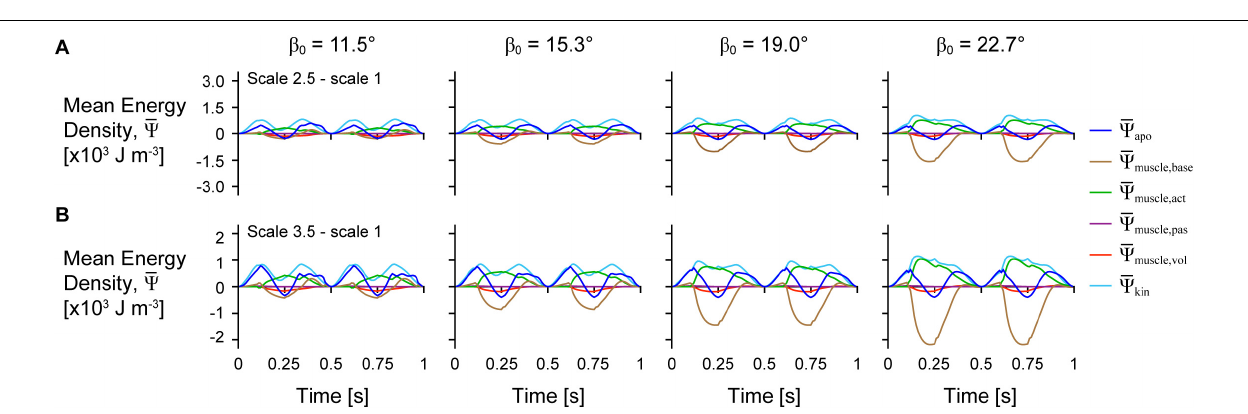
FIGURE 3 | Tissue energy over time across initial pennation angles. Simulation traces of mean energy-density ψ over time for geometries with different initial pennation angles relative to the x -axis β 0 at scale 1 and with a maximum strain of 5% and normalised excitation of 1. (A) Shows all of the energy components and (B) shows only the passive, kinetic, and volumetric components from (A) with the y -axis rescaled to visualise changes in these smaller components.